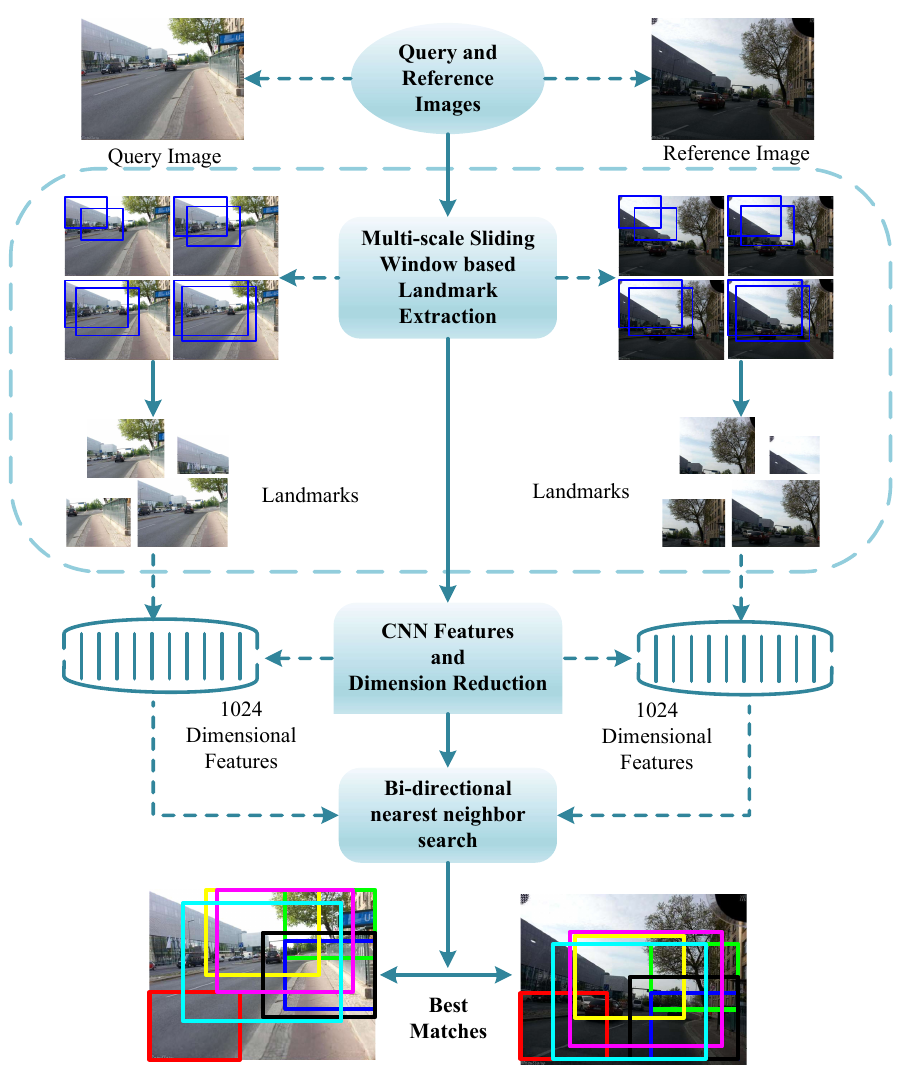
Figure 2. Overview of our MSW based visual place recognition method. First, 100 landmarks are extracted from different scales by MSW strategy. Next, 1024-dimensional CNN features are computed for representing the landmarks before the bi-directional nearest neighbor search conducted to match pairwise landmarks. Thus, the best pairwise match is obtained by pooling all the pairwise matching results for similarity measure.